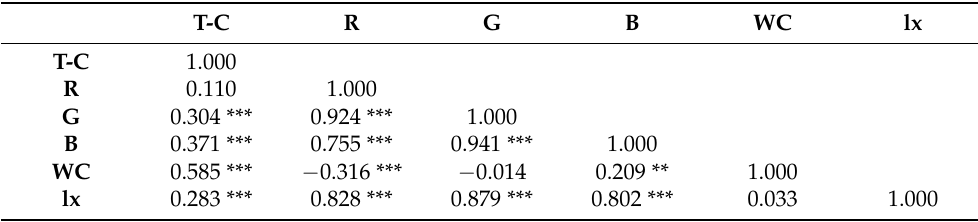
Table 4. Pearson correlation coefficient table of the OS soil components. T-C R G B